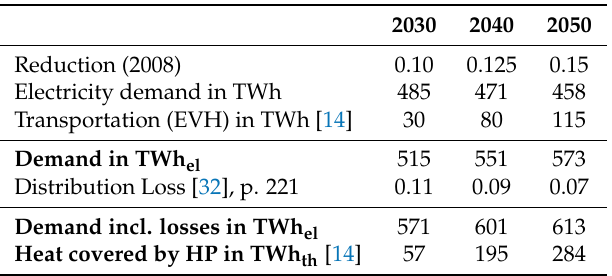
Table 1. Electricity demand values are based on the German efficiency goals. For the GS scenario it is assumed that a reduction of 25% and for GL 15% reduction is